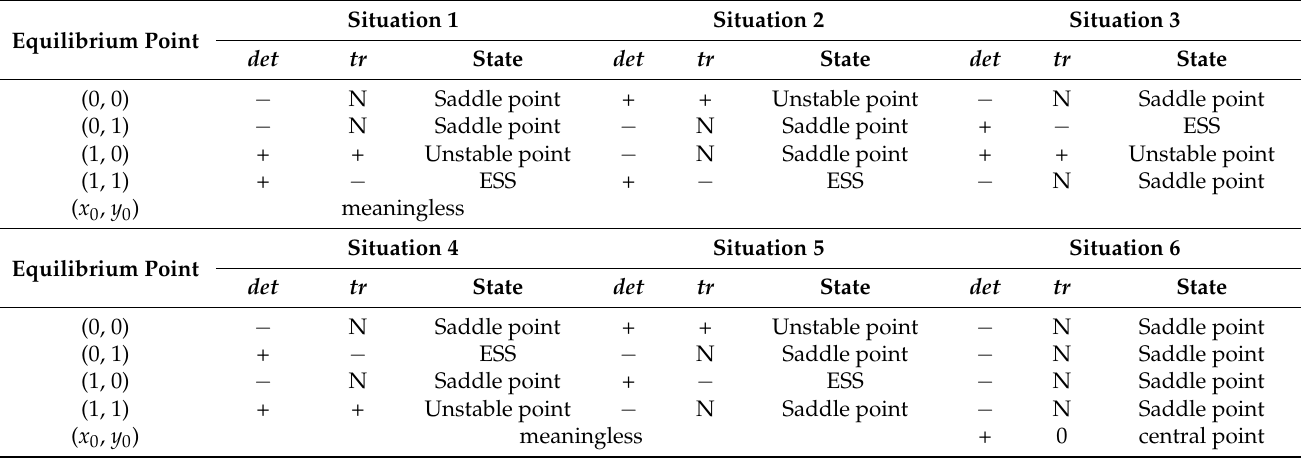
Table 4. Local stability analysis of equilibrium